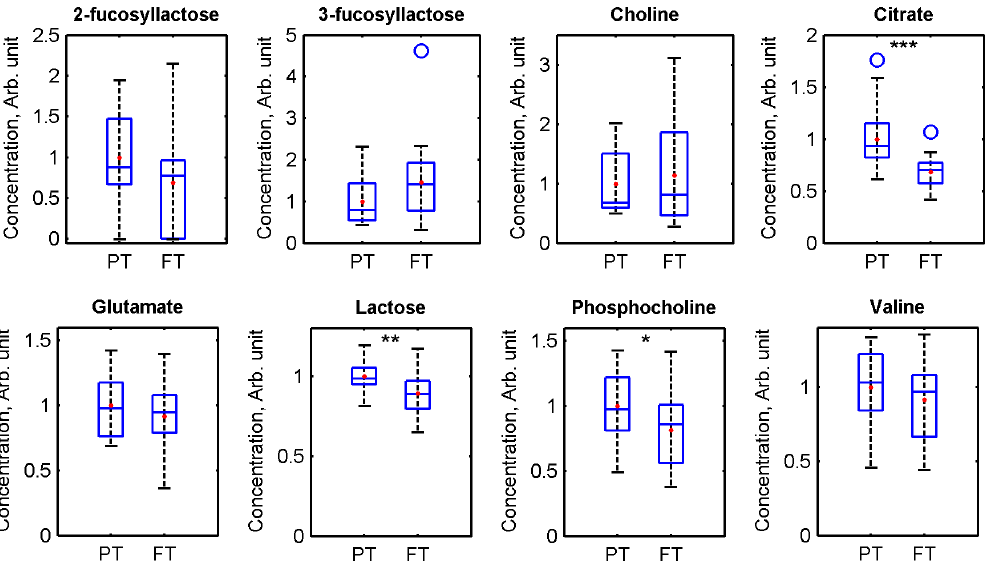
Figure 4. Box plots showing the distributions of 2 ‐ fucosyllactose, 3 ‐ fucosyllactose, choline, citrate, glutamate, lactose, phosphocholine, and valine concentrations in pre ‐ term (PT) and full ‐ term (FT) milk. Pre ‐ term milk samples <14 days postpartum and full ‐ term colostrum, transitional, and mature >26 weeks were excluded from the analysis in order to compare milk with a similar range of days postpartum. Horizontal lines indicate medians; coloured boxes specify interquartile ranges and dashed lines the ranges without outliers. The open circles indicate outliers (falls in ‐ between 1.5× and 3× the interquartile range). *** = P < 0.001, ** = P < 0.01, * = P < 0.05; the comparisons were made using two ‐ tailed Student’s t ‐ test. Nutrients 2016 , 8 , 304